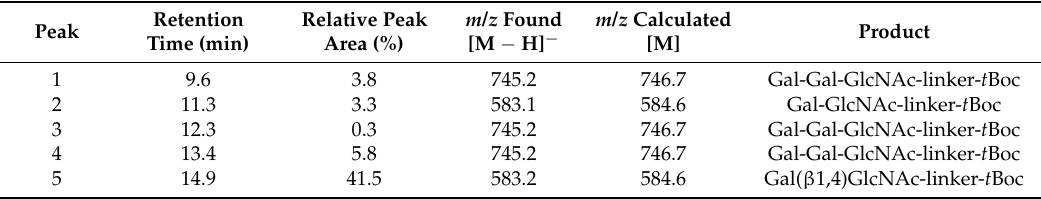
Table 3. Observed molecular mass of isolated product fractions analyzed on analytical HPLC. Transgalactosylation reaction (10 mM β - D -GlcNAc-linker- t Boc, 600 mM lactose and 12 U/mL enzyme solution) under thermal heating for 30 min at 85 ˝